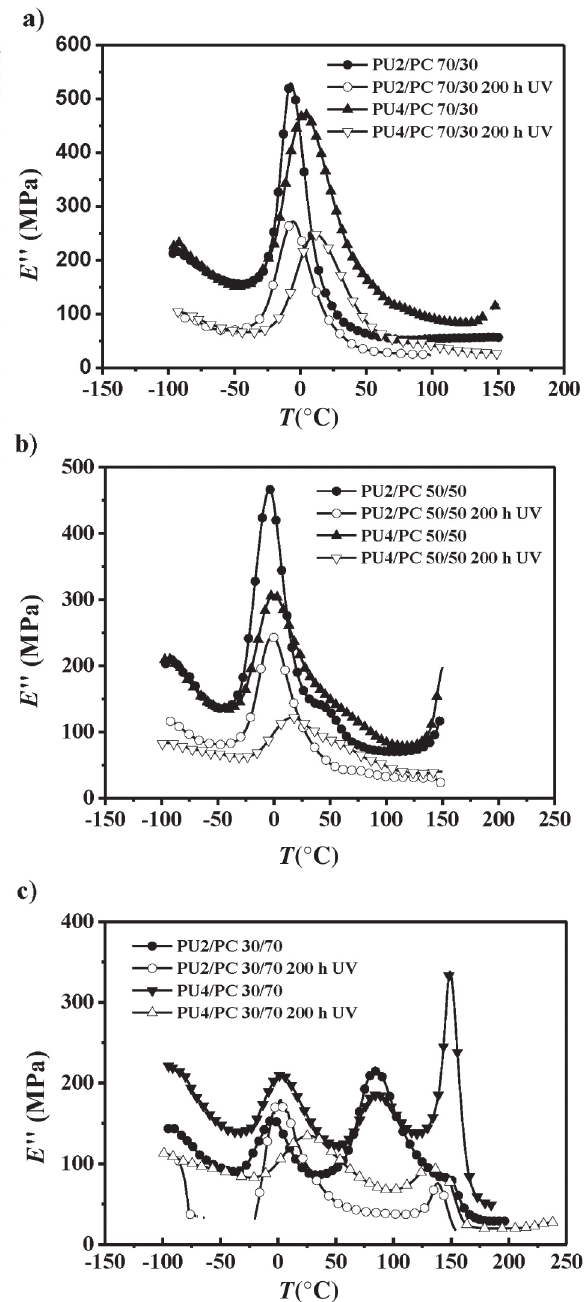
Fig. 5 – loss modulus (E’’) for Pu/Pc a) 70/30, b) 50/50, and c) 30/70 blends as a function of temperature before and after UV